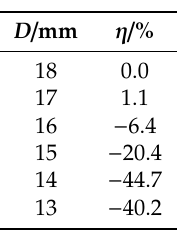
Figure 14. Cross-section of the tube (ball diameter Φ b = 15.9 mm, pushing pitch f R = 0.042 mm/rev). Table 4. The thickness increasing ratio η . Table 4. The thickness increasing ratio η .